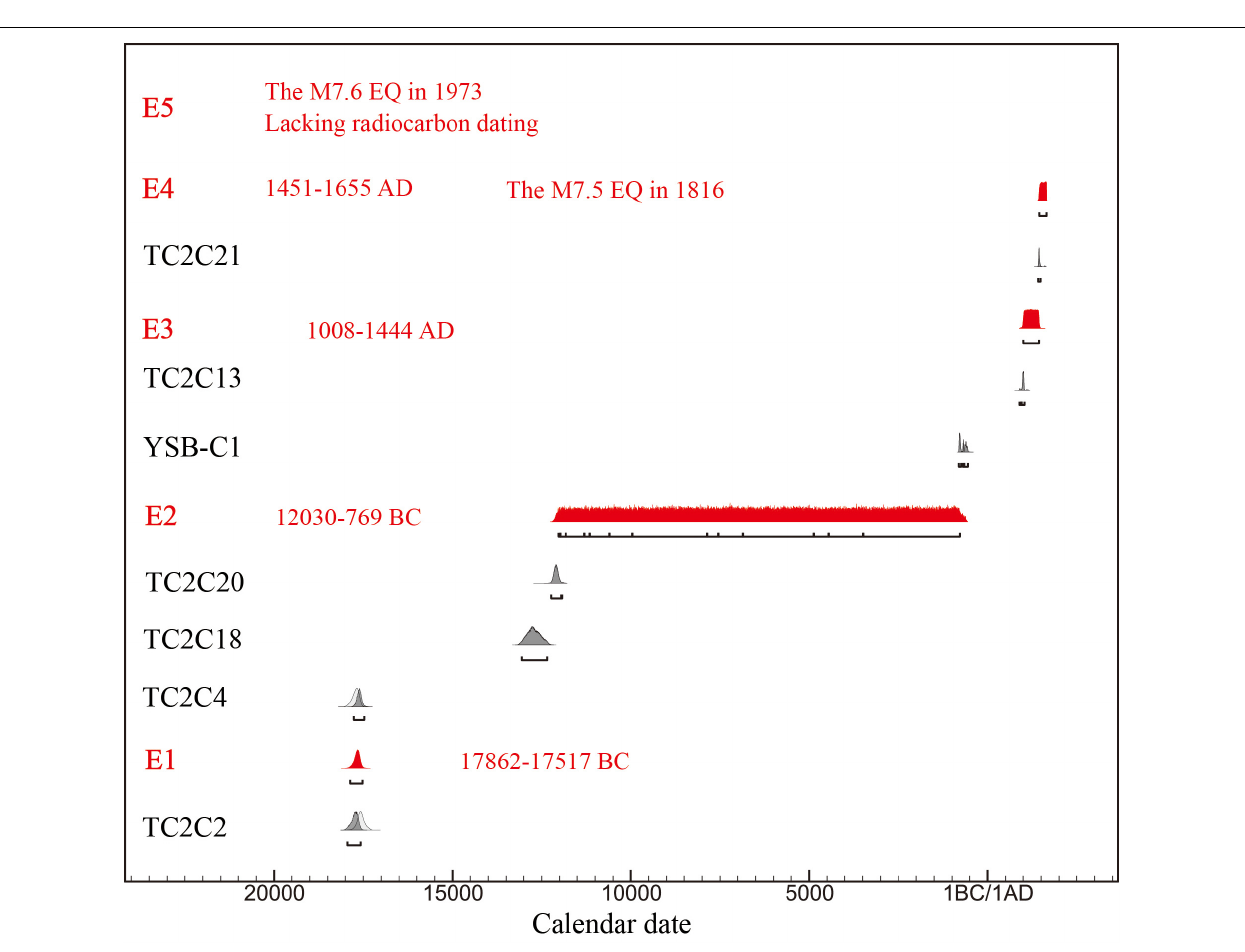
in TC1 is 1008–1444 AD, which is consistent with the date